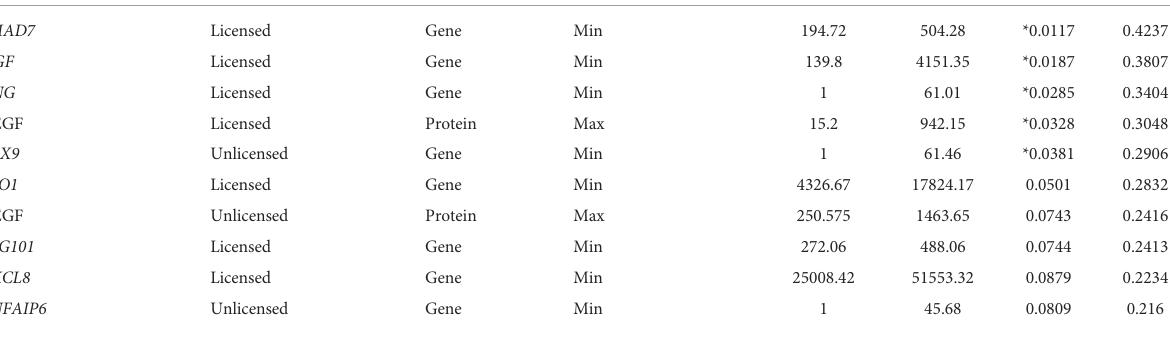
SummaryofregressionanalysesbetweenHUVECPC1compositescoresandMSC(AT)genes,solublefactors,andmorphologicalfeatures.Marker/Characteristiccolumnindicatesthegene or protein symbol, or morphological feature. Licensed/Unlicensed column indicates whether the factor was measured under licensed or unlicensed conditions. Min/Max Function column indicates whether minimization or maximation of the MSC(AT) characteristic was desirable based on positive or negative correlations in the linear regression analysis. Min value and